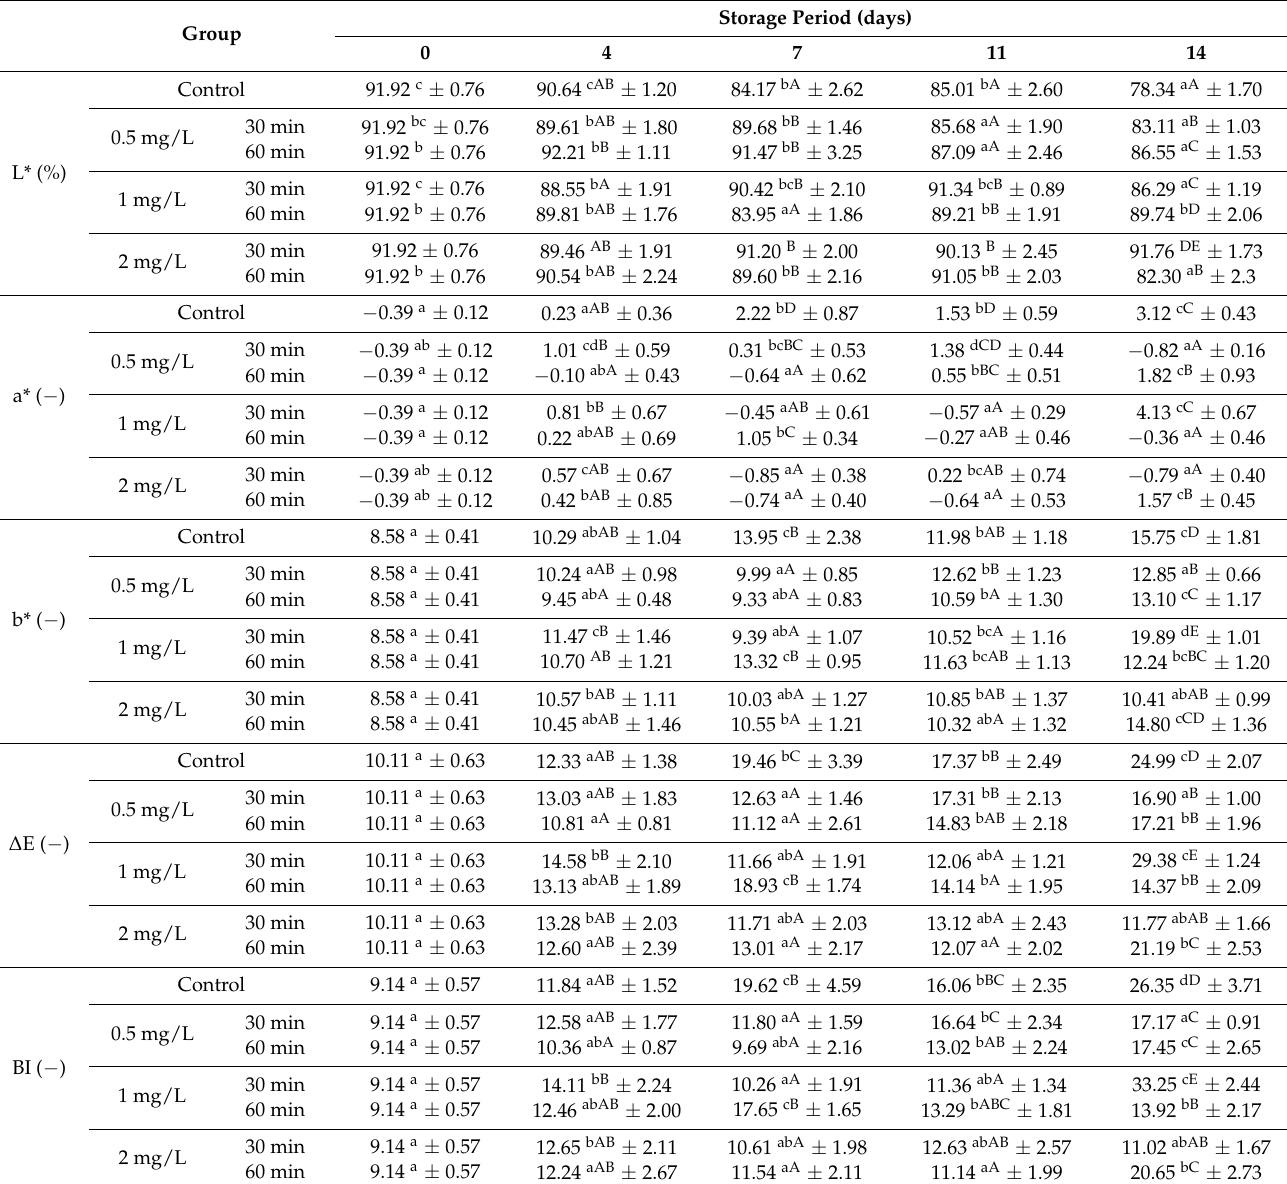
Table 4. Impact of ozone dose, time of ozonization, and storage time on the internal color parameters of the Agaricus bisporus measured at 0, 4, 7, 11, and 14 days of